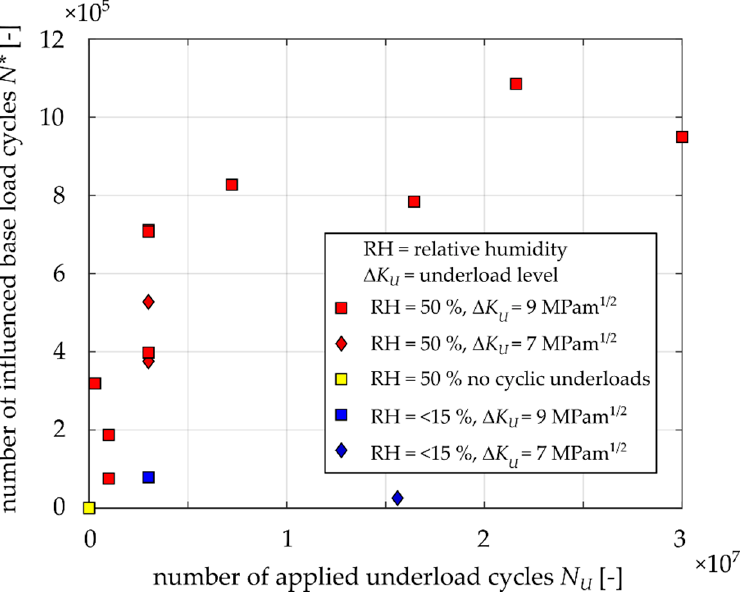
Figure 11. Experimentally obtained numbers of influenced load cycles N * after underloads.